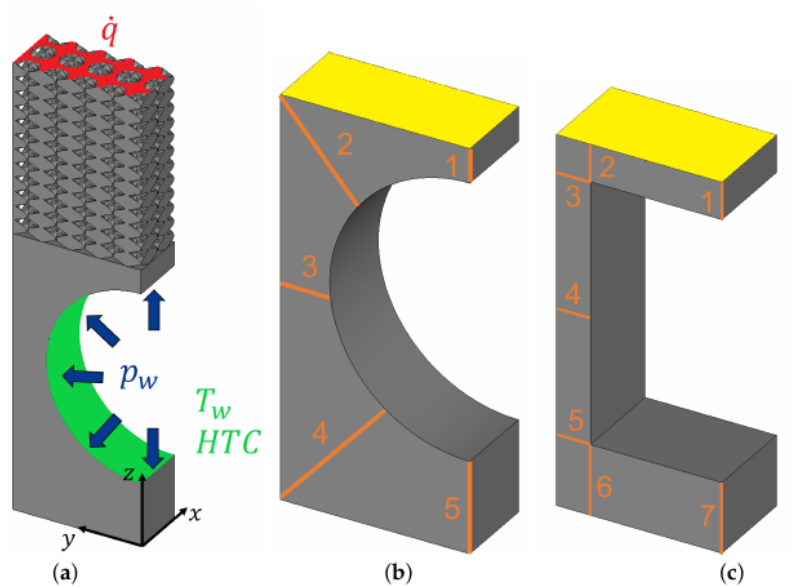
Figure 3. ( a ) Representation of the geometric domain of the 3D model and the applied boundary conditions. In order to save a considerable amount of computational resources, only half of the PF was reproduced in the solid model, using the symmetry of the geometry with respect to the x − z plane; ( b , c ) paths traced within the heat sink geometry for the structural verifications required by SDC-IC standards, for Configurations 1 and 2,